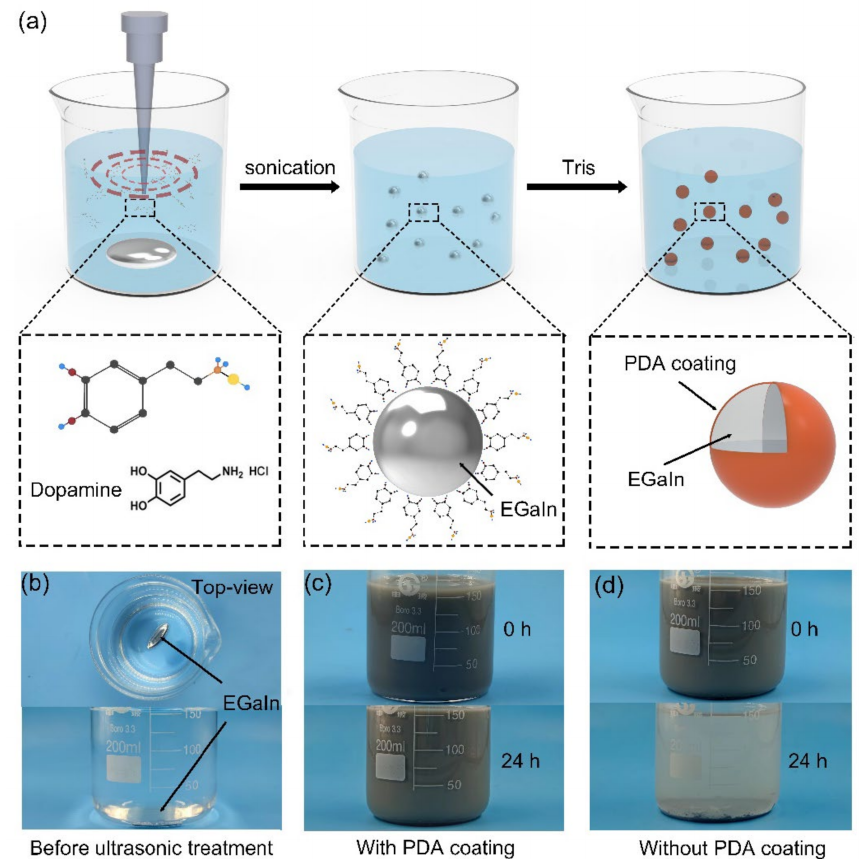
Figure 1. ( a ) Schematic of the fabrication process of the PDA-EGaIn nanocapsules. Images of the EGaIn droplet ( b ) before and after sonication ( c ) with the PDA coating and ( d ) without the PDA